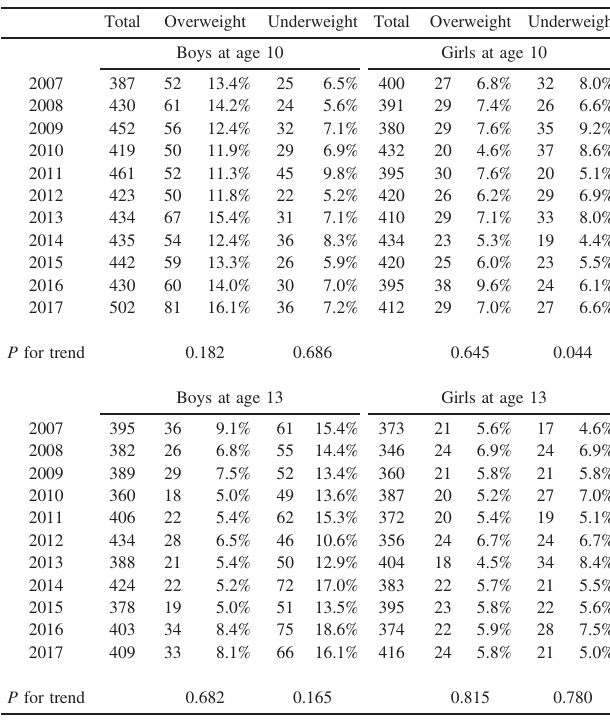
Table 2. Secular trends in overweight and underweight children (numbers and proportions) Total Overweight Underweight Total Overweight Underweight Boys at age 10